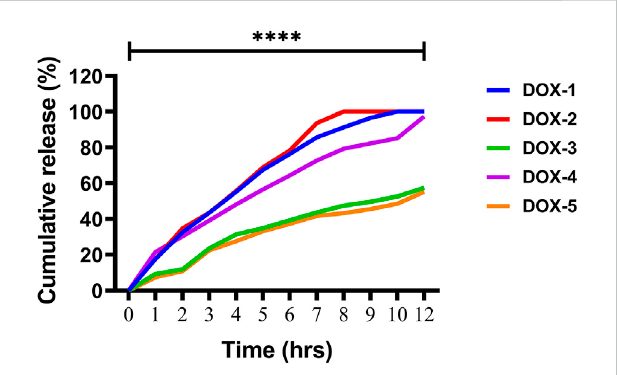
FIGURE 11 In-vitro drug release of the DOX